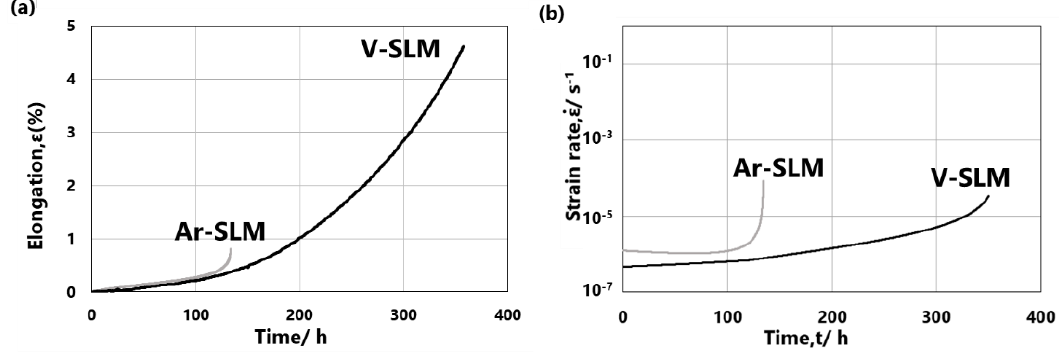
Figure 7. Creep curves of HT specimens at 650 °C under 550 MPa: ( a ) creep strain–time curves and ( b ) creep strain rate–time curves.